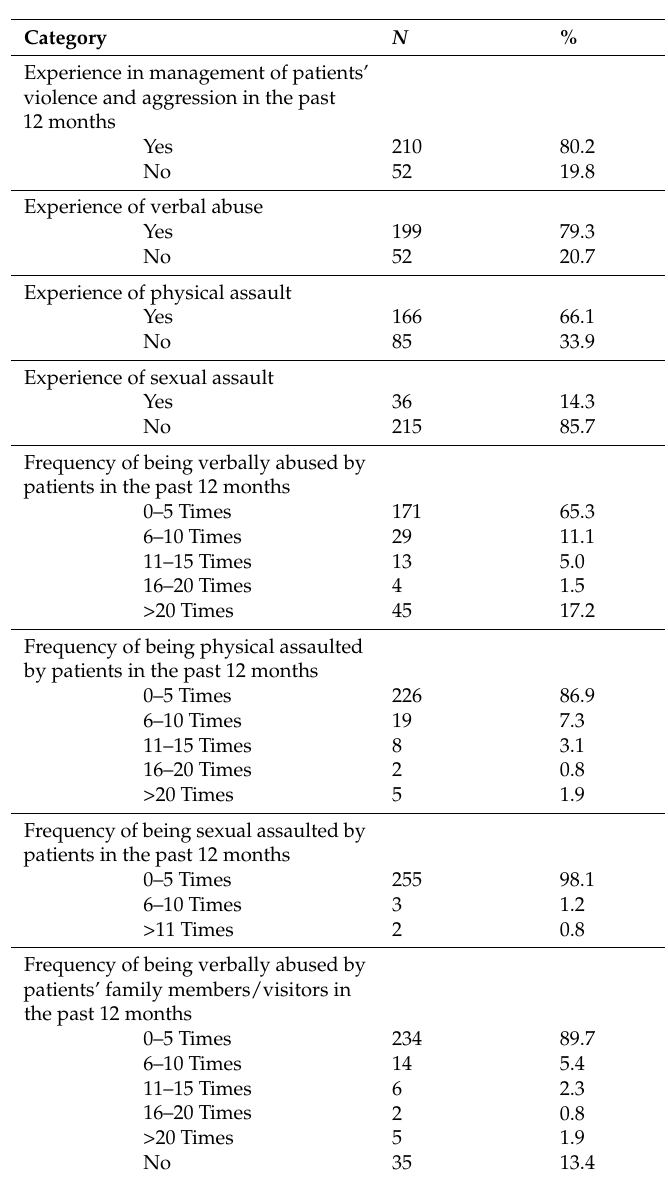
Table 2. Participants’ experience of WPV in the past 12 months ( N =